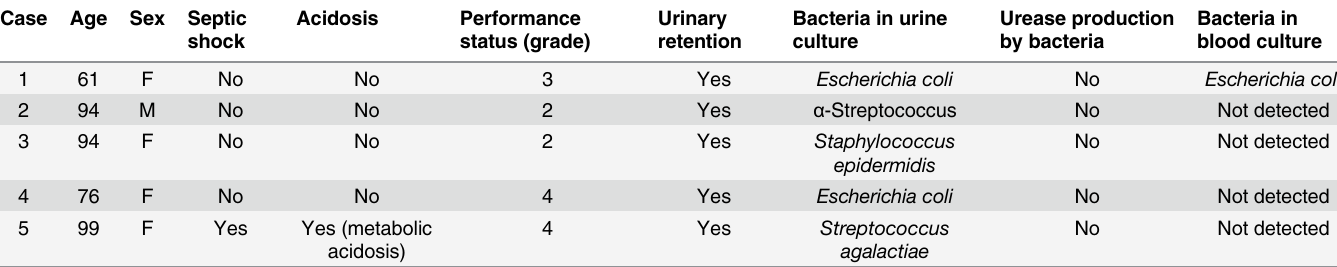
Table 4. Clinical characteristics of five cases with high plasma ammonia levels.